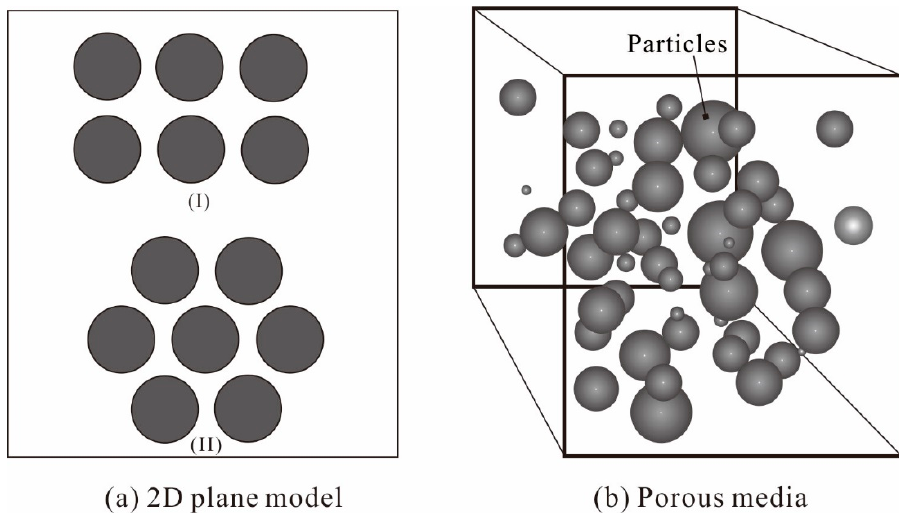
Figure 1. Schematic diagram of porous media model.